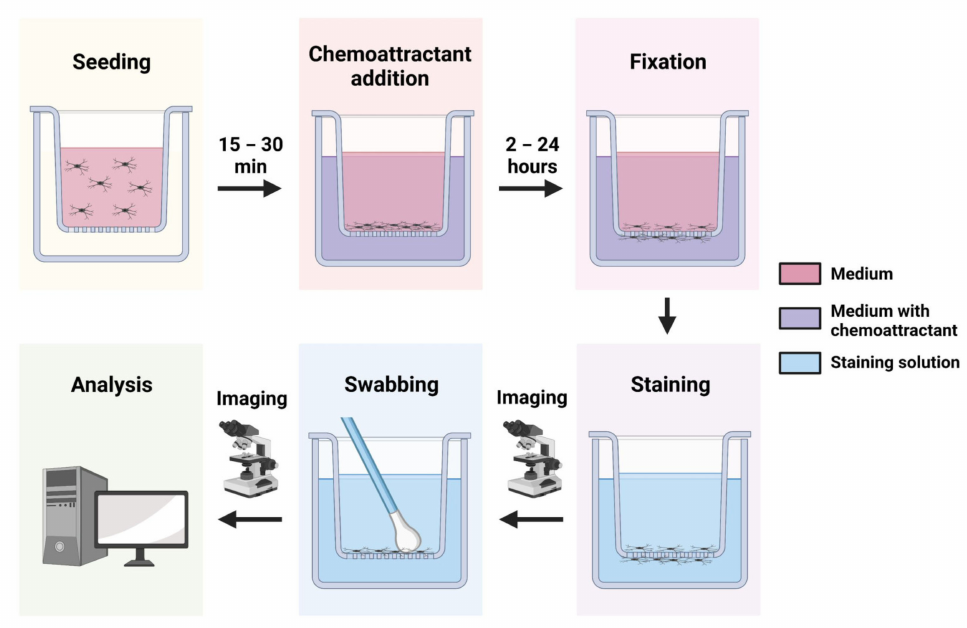
Figure 3. Transwell assay workflow. Microglia are seeded into transwells and can be left to adhere to the membrane for up to 30 min. A defined chemoattractant is then added to the bottom chamber and microglia are allowed to migrate through the membrane for a defined timespan. Cells are fixed and stained. Light microscopy at a low magnification is used to image the inserts allowing visualization of all cells either side of the membrane. The inserts are then swabbed on the top side with a cotton wool bud to remove the unmigrated cells, and imaged again to visualise migrated cells only. Image analysis software is used to count cells, and the result is expressed as a ratio or percentage of migrated cells (after swabbing) relative to the total cell population (before